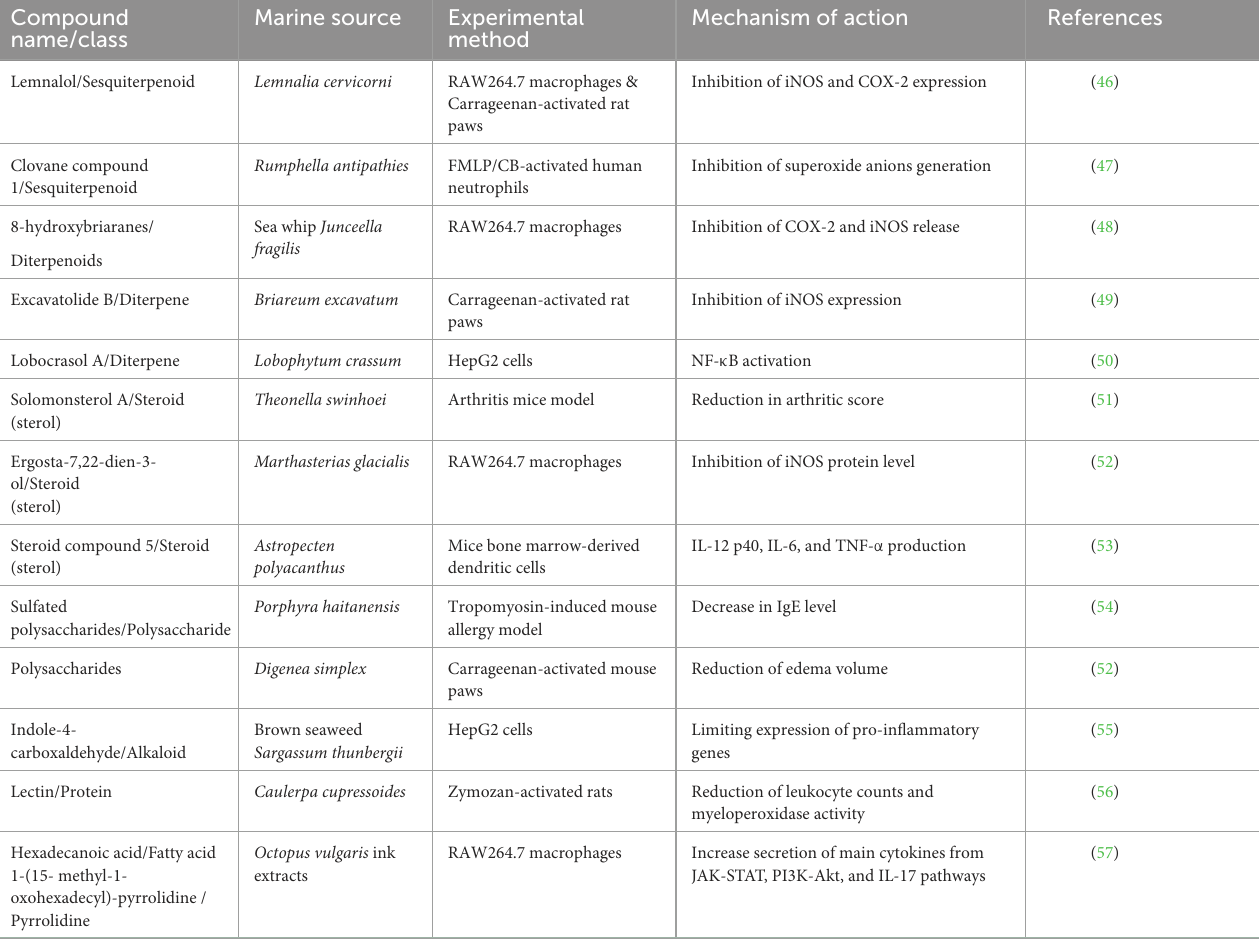
TABLE 2 List of selected compounds isolated from marine sources with potential anti-inflammatory and anti-oxidant